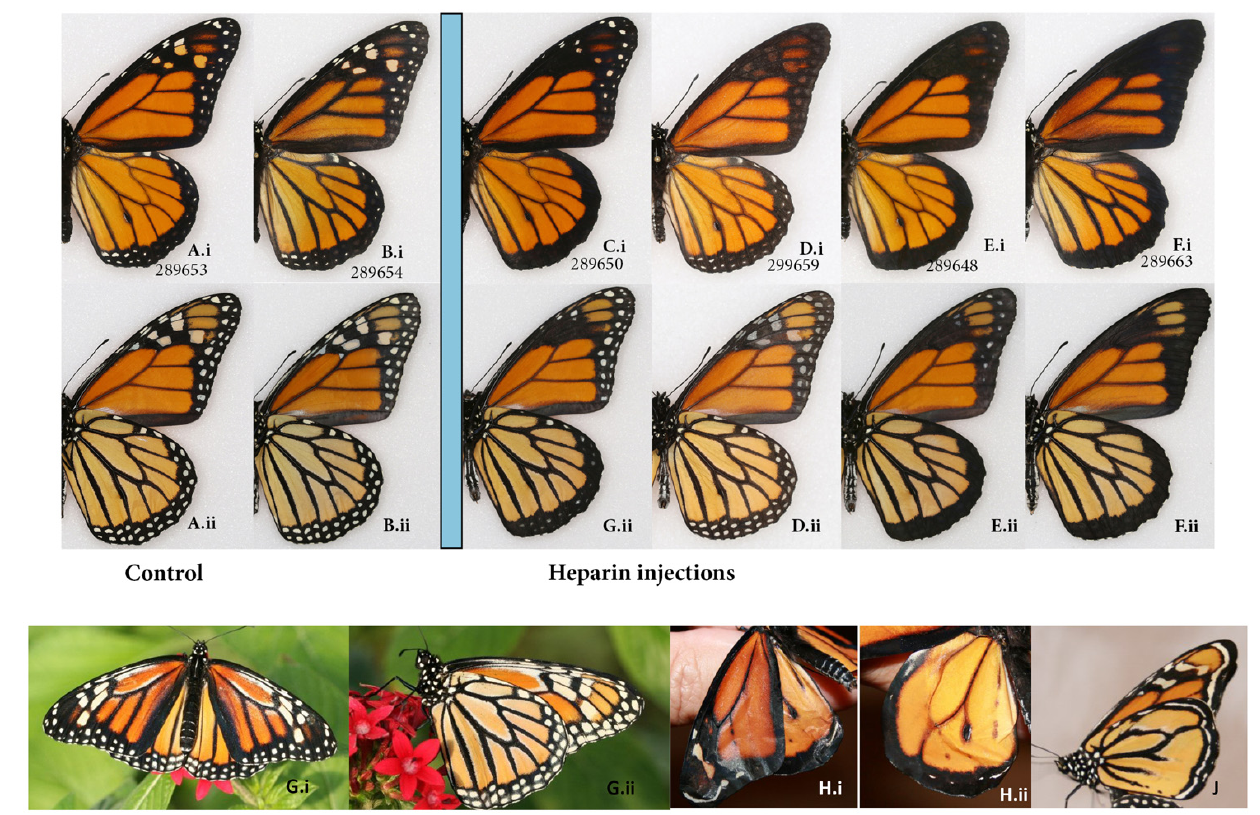
Figure 4. The monarch, Danaus plexippus . ( A – B ) Wild type vs. ( C – F ) heparin-induced wing pattern when injected as pupae or prepupae; dorsal ( i ) and ventral ( ii ) surfaces. ( A , C , D , E ) males ( B , F ) females. Aberrant monarchs, with extra white spots ( G ) and without veins ( H , J ), courtesy of Edith Smith. See Extended Data (Sourakov, 2020) for